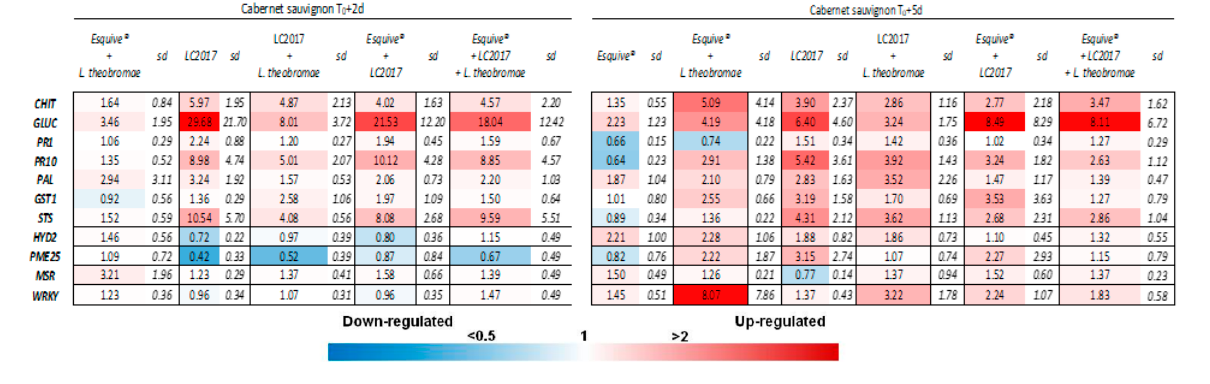
Figure 4. Expression levels of selected genes (determined with quantitative reverse-transcription polymerase chain reactions) and relative standard deviation values (sd) recorded on leaves cv Cabernet Sauvignon at T0 + 2d and T0 + 5d. The values (each the mean of three technical replicates) represent expression levels ( ΔΔ Ct) of treatments relative to the control (condition Esquive ® T0 + 2d). The expression of each gene was considered up-regulated when the value was >2-fold compared to the controls or down-regulated when the value was <0.5-fold compared to the controls.